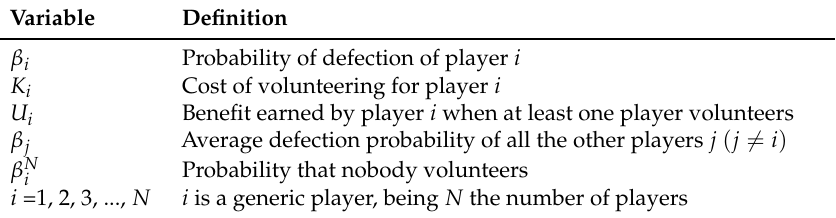
Table 1. Definitions of the variables presented in the Asymmetric Volunteer’s